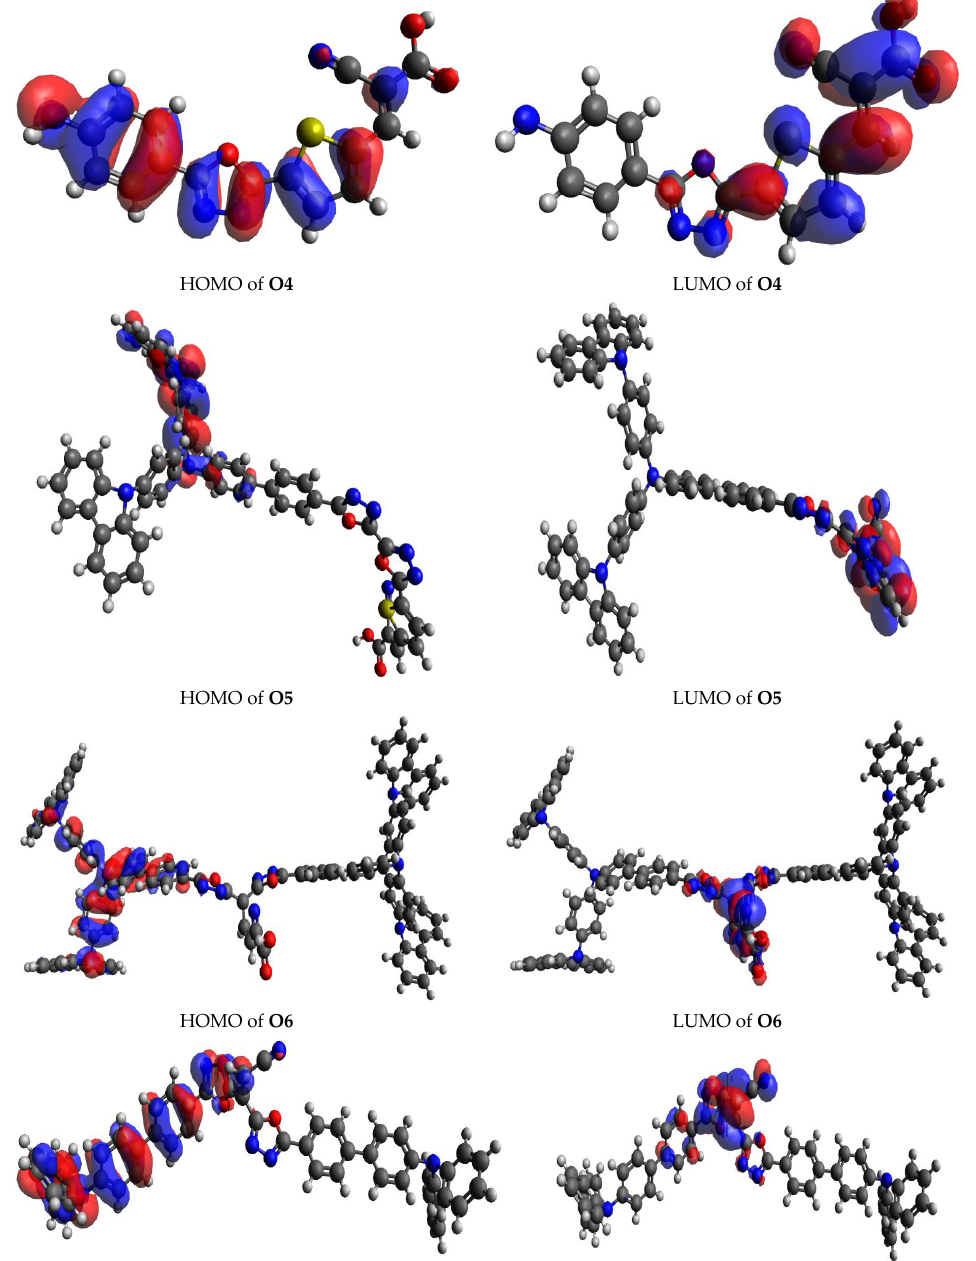
Figure 6. The highest occupied molecular orbitals of molecules in their respective ground states and lowest unoccupied molecular orbitals of molecules in their respective excited states.